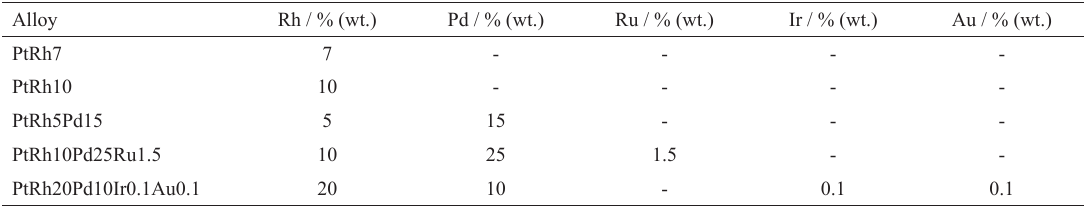
Table 1: The content of alloying elements in the investigated alloys (mass%) Alloy Rh / % (wt.) Pd / % (wt.) Ru / % (wt.)